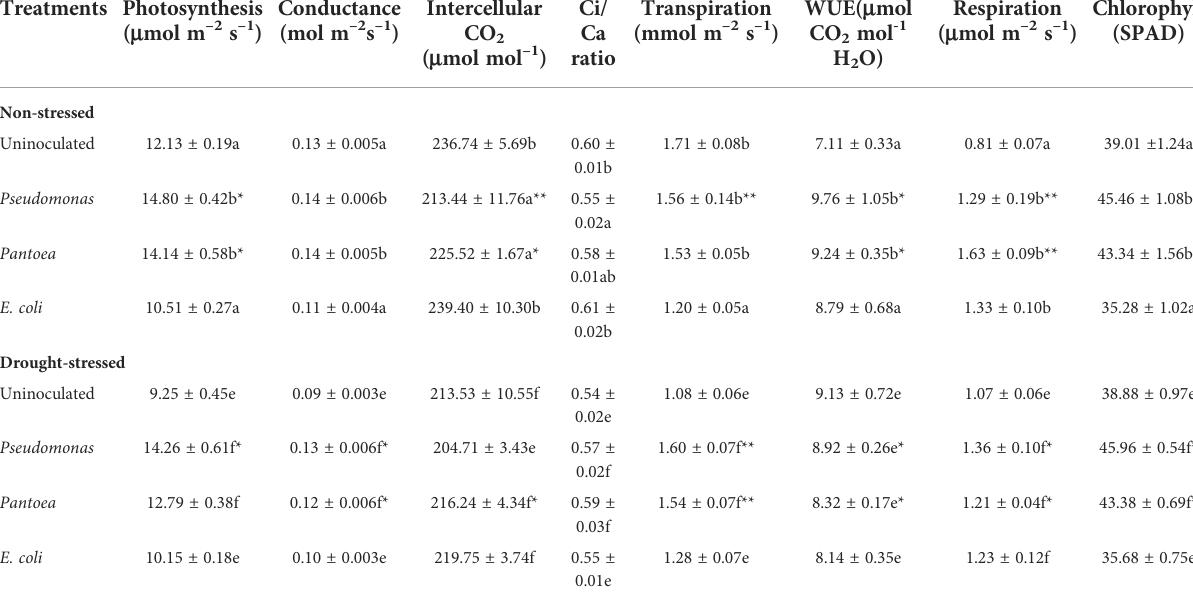
TABLE 1 Photosynthesis, stomatal conductance, intercellular carbon dioxide (Ci) and ratio of intercellular CO 2 with atmospheric CO 2 (Ci/Ca), transpiration, water use ef fi ciency (WUE), and respiration of drought-stressed and non-stressed (well-watered) Hordeum vulgare inoculated with three bacterial strains ( Pseudomonas sp. (ITS Group 11), Pantoea sp. (ITS Group 2), or E. coli ).